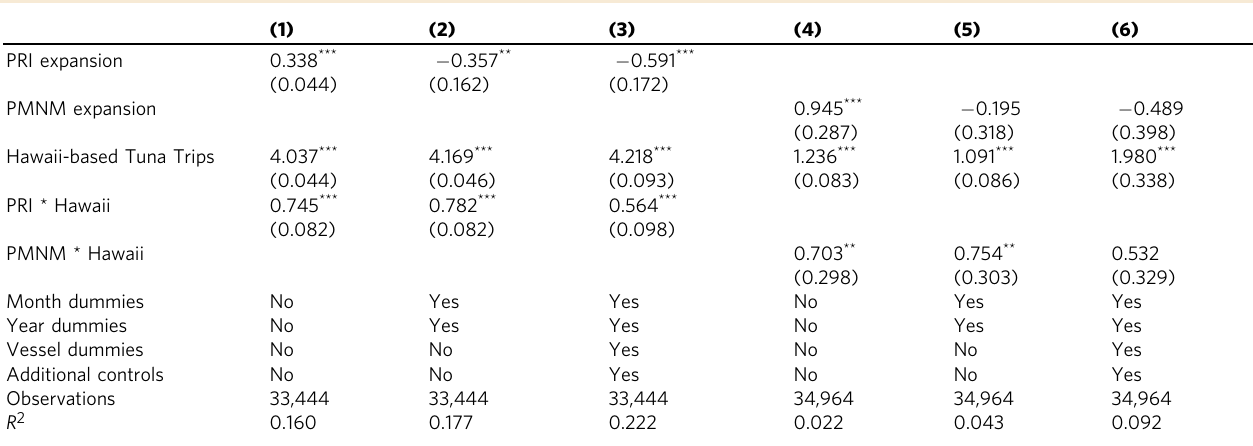
Table 2 Difference-in-differences